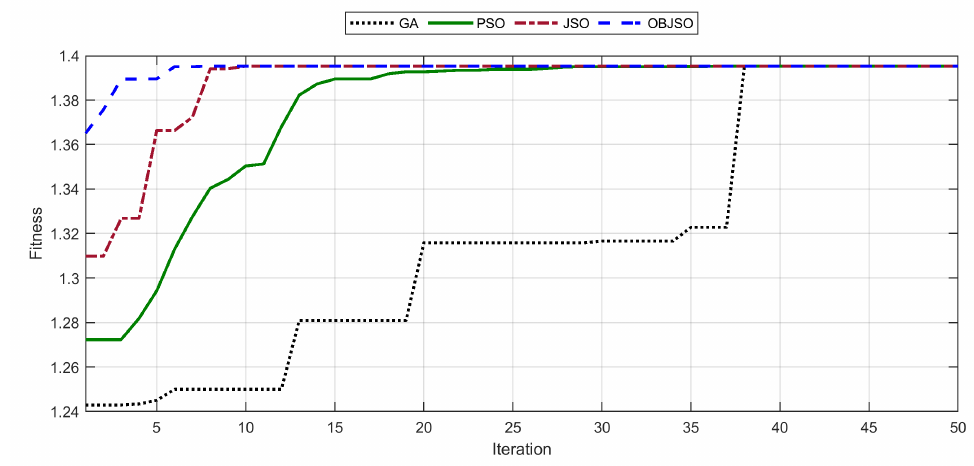
Figure 6. Convergence curves for best fitness value.